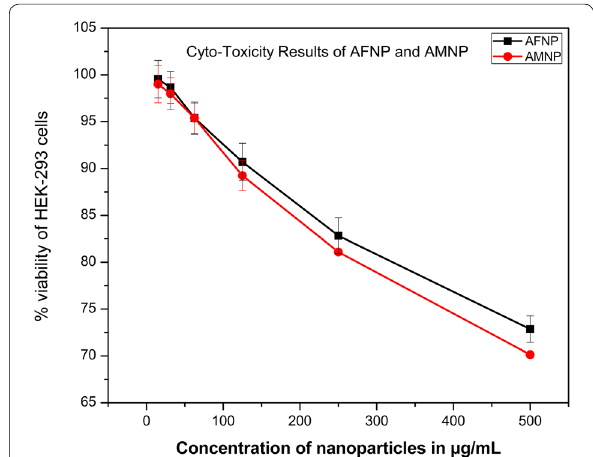
Fig. 8 Graphical representation of the toxicity of the nanoparticles on HEK-293 cell line through MTT